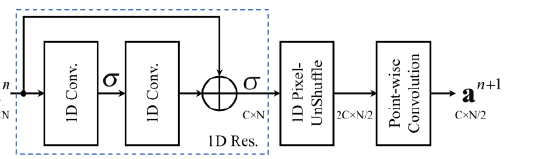
Figure 6. Layer structure of encoders 1 – 7; C and N are the numbers of input channels and features, respectively.